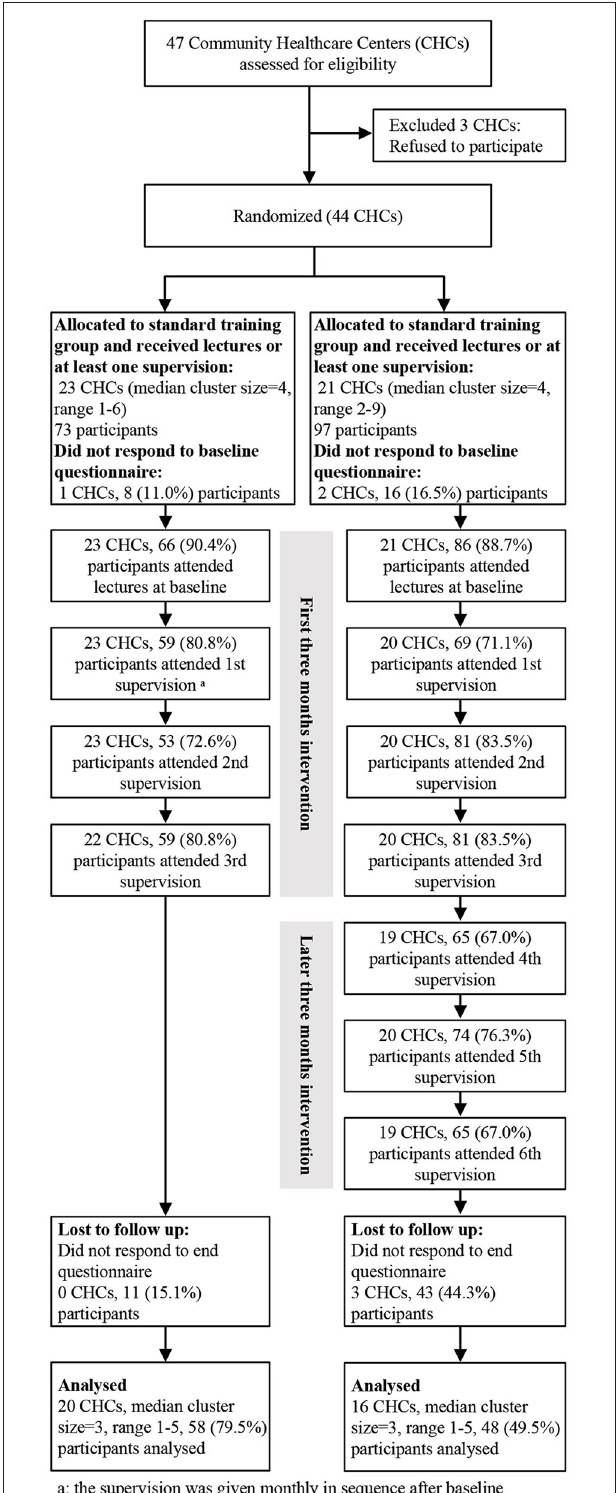
FIGURE 1 | Flow diagram of the sample frame and data